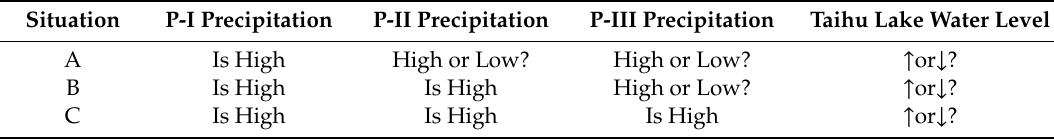
Table 9. Situation-setting of precipitation in the plum rain period.